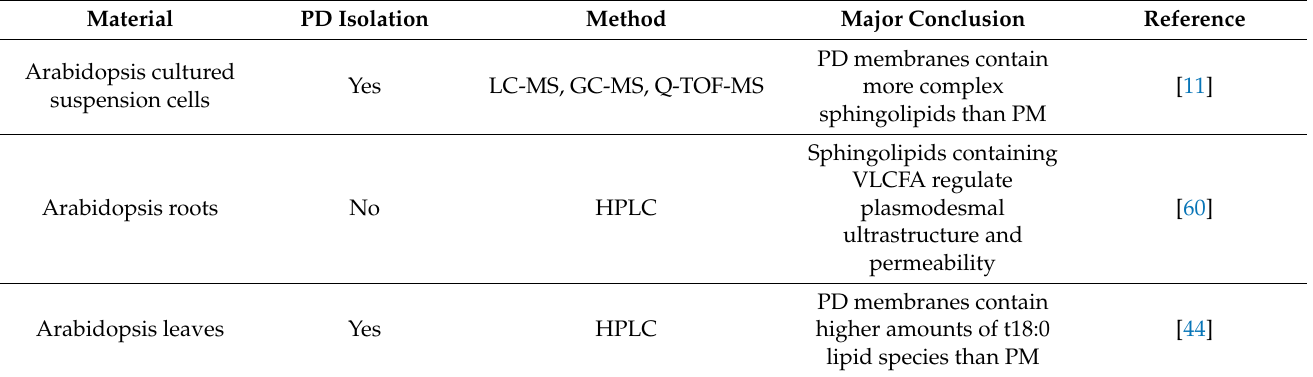
Table 1. Plant sphingolipid profiles for plasmodesmata (PD) functional